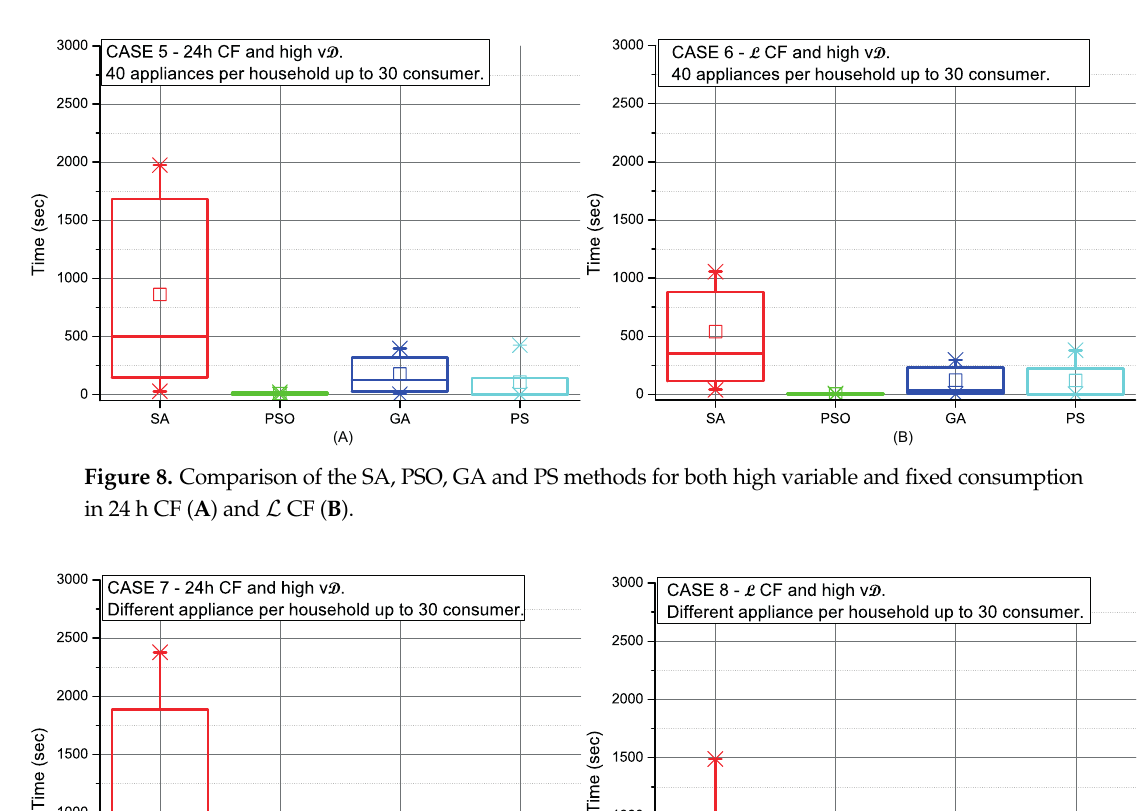
Figure 7. Comparison of the SA, PSO, GA and PS methods for low variable and high fixed consumption in 24 h CF ( A ) and L CF ( B ).